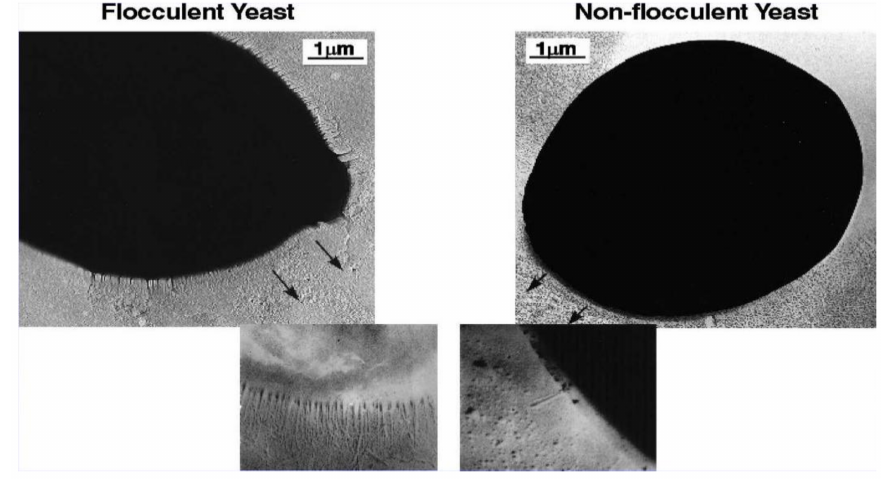
Figure 8. Electron photomicrograph of Saccharomyces cerevisiae flocculent and non-flocculent strains shadow-cast with tungsten oxide [33].